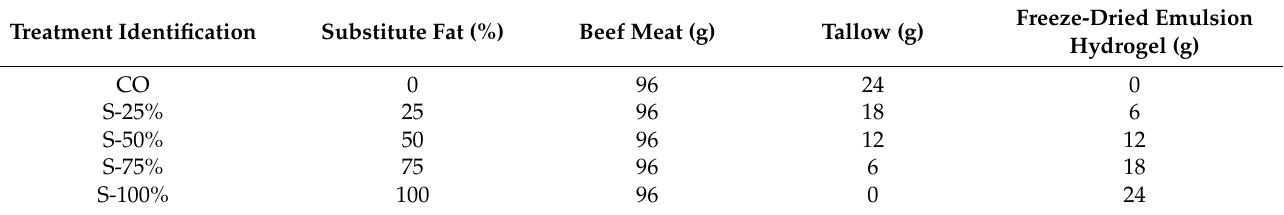
Table 6. Formulations of beef burger with substitute fat (konjac flour, sodium alginate, linseed flour, encapsulated açai oil), CO—control (0% substitute fat), S-25%—25% substitute fat,